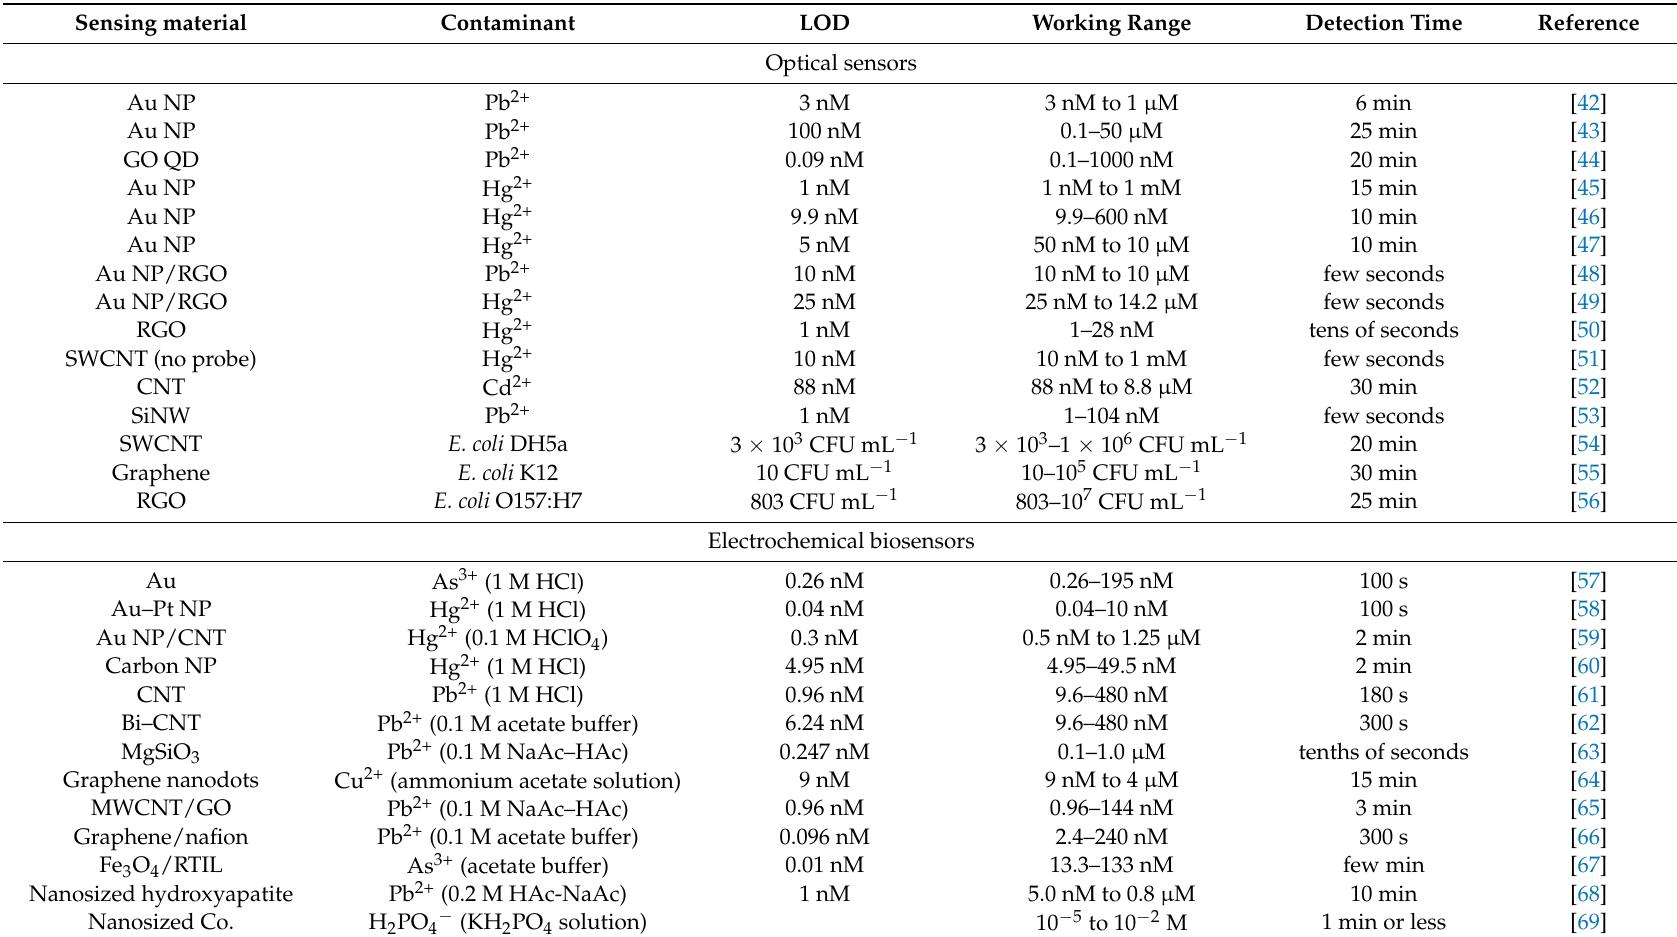
Table 2. Optical biosensors and electrochemical biosensors used for rapid water contaminants e.g., toxic heavy elements